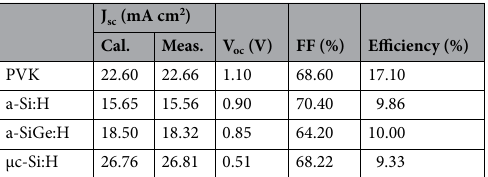
Table 1. Calculated J sc and performance metrics of various top sub-cell candidates.